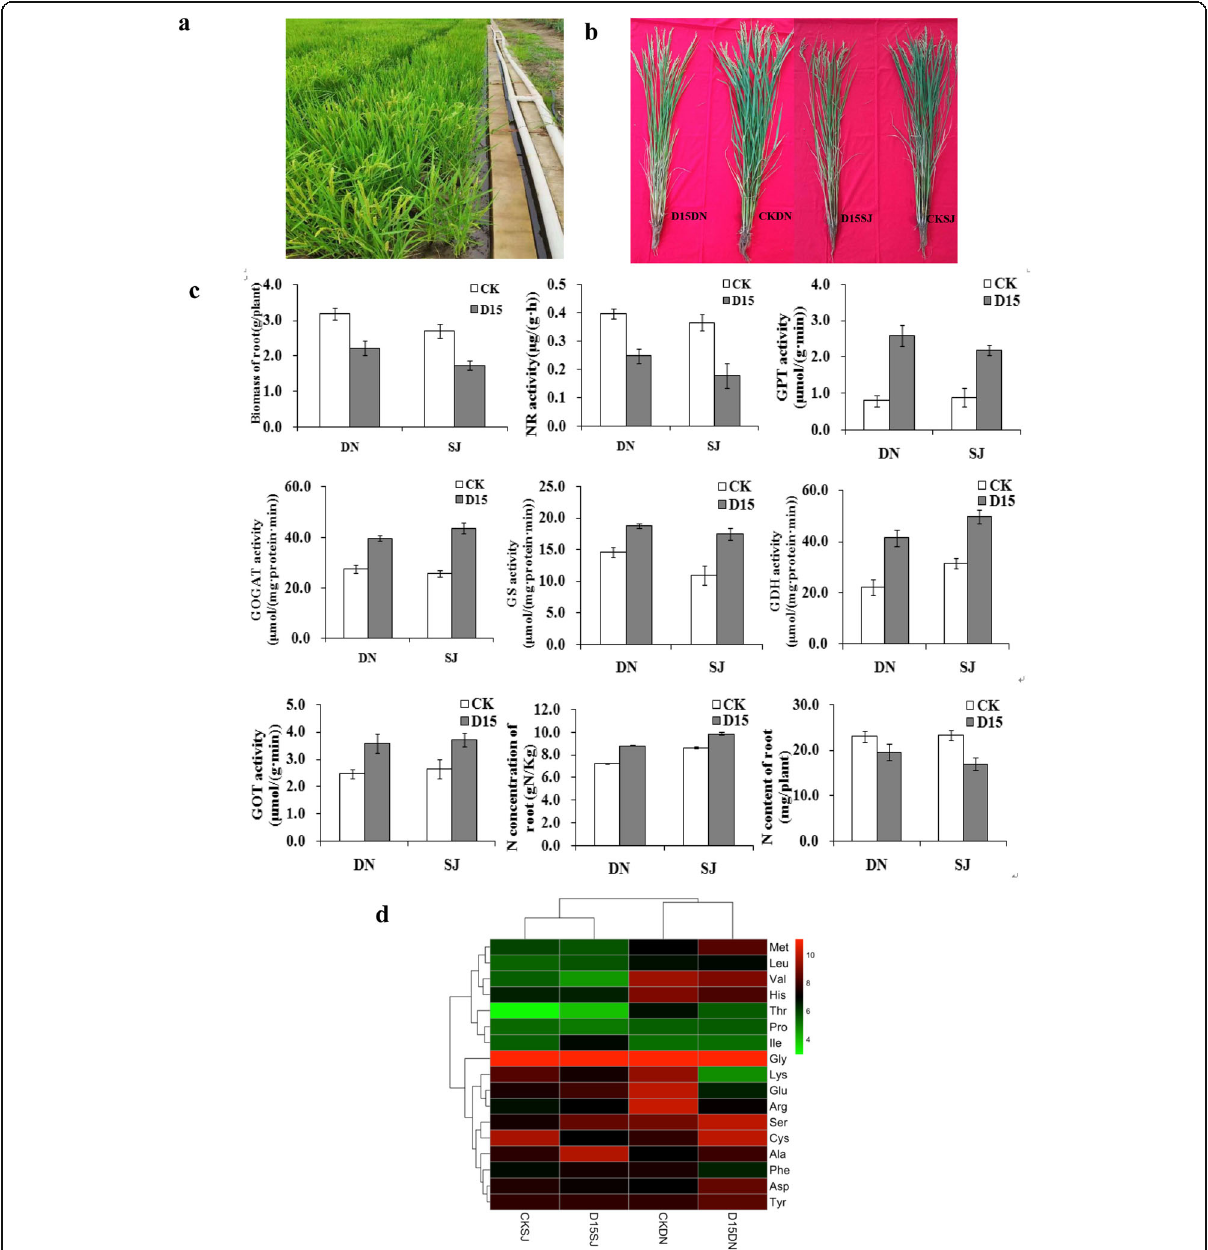
Fig. 1 Phenotypic and physiological responses of two rice cultivars with low-T w treatment during reproductive growth. a. The plots of cold water treatment in the field b, Plants of Dongnong428 (DN) and Songjing10 (SJ) cultivars under low-T w treatment at the full heading stage. c, Nitrogen (N) concentration, and nitrate reductase (NR), glutamate synthase (GOGAT), glutamine synthetase (GS), glutamate dehydrogenase (GDH), aspartate aminotransferase (GOT), and alanine aminotransferase (GPT) activities in the control (CK) plants and after 15 d of the low-T w treatment. d, Differences in the amino acid contents of the CK and 15 d low-T w treatments of DN and